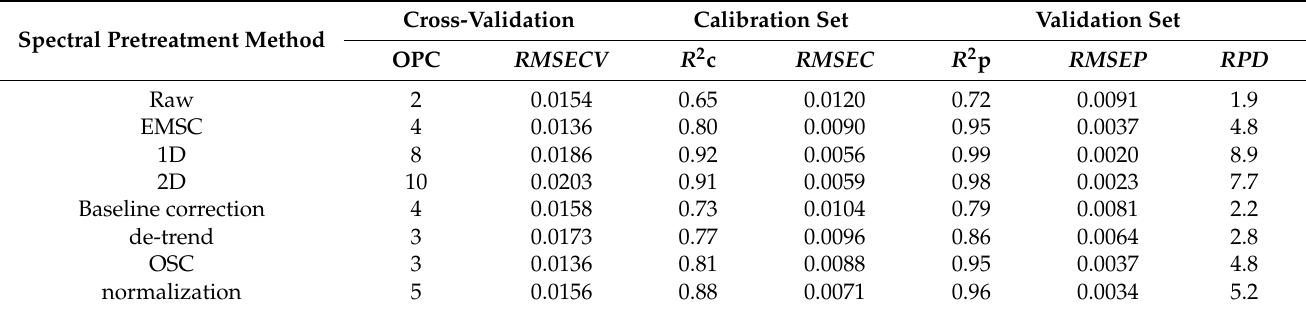
Table 3. PLS regression models for the carbon content of tree species based on different pretreatment.